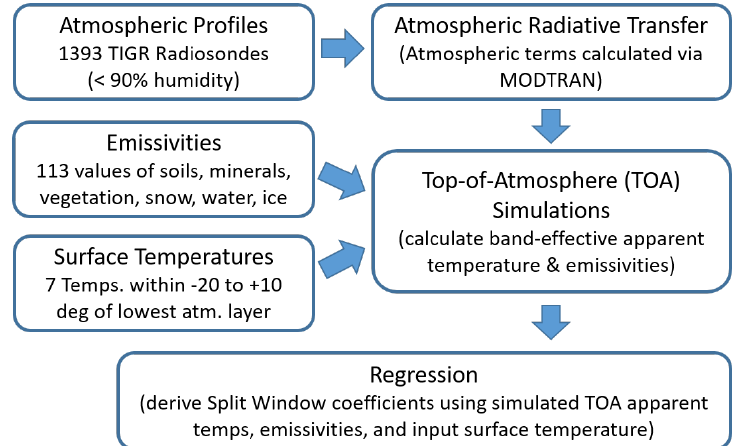
Figure 1. Process flow to derive split window coefficients by propagating modeled surface temperatures, emissivities, and atmospheric conditions to the top of atmosphere and regressing the band-effective apparent temperatures against the known input surface